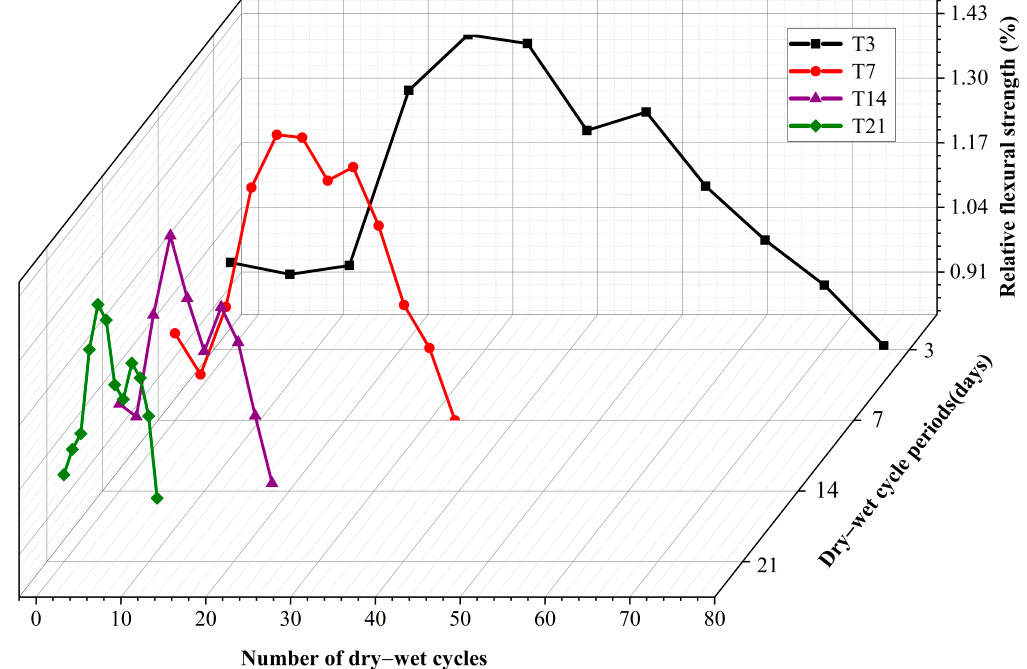
Figure 7. Variation of relative flexural strength among different dry-wet cycle